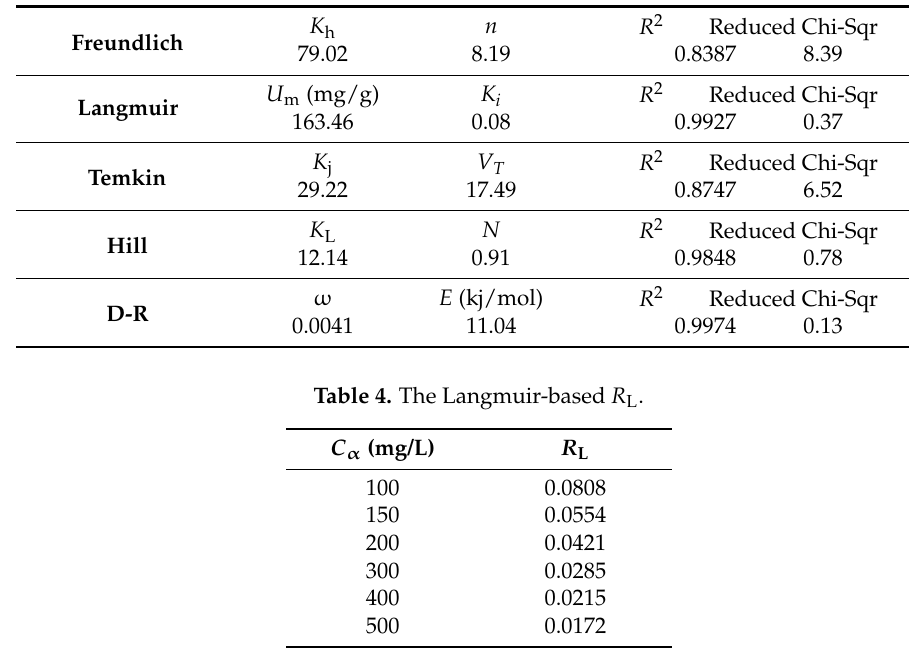
Table 3. Adsorption isotherms parameters for Ag(I) on BA-PGMA.